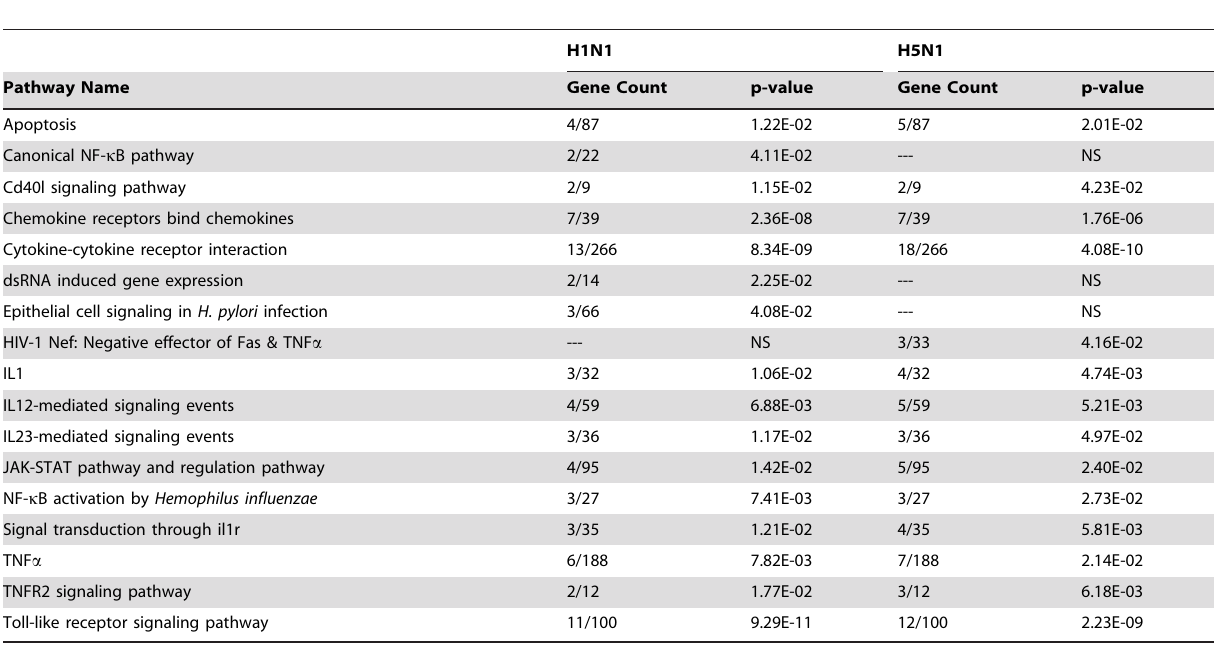
Table 3. Significantly enriched pathways in the response to H1N1 and H5N1 infection.